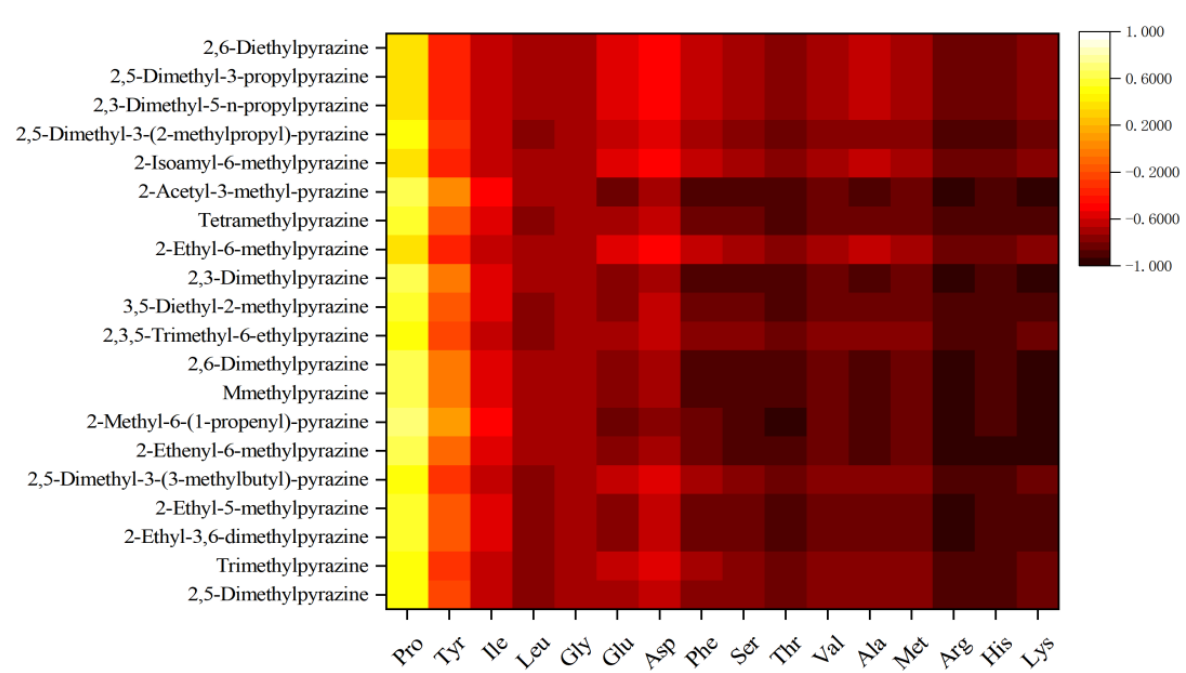
Figure 3. Pearson correlation coefficient diagram of pyrazines and amino acids.